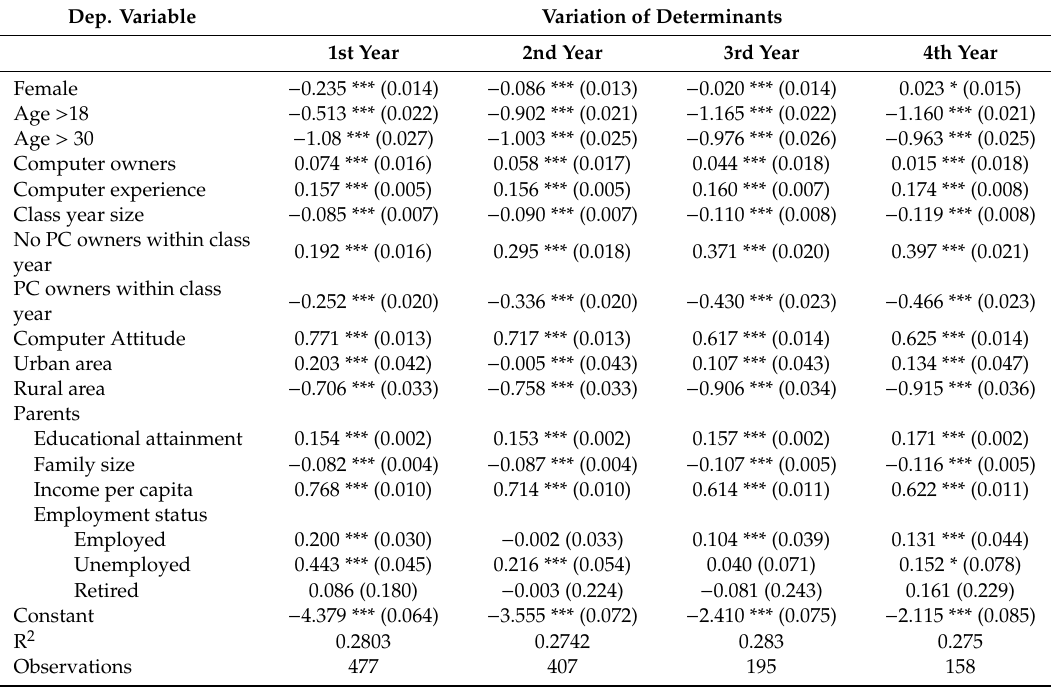
Table 8. Computer property logistic regression estimates for undergraduate